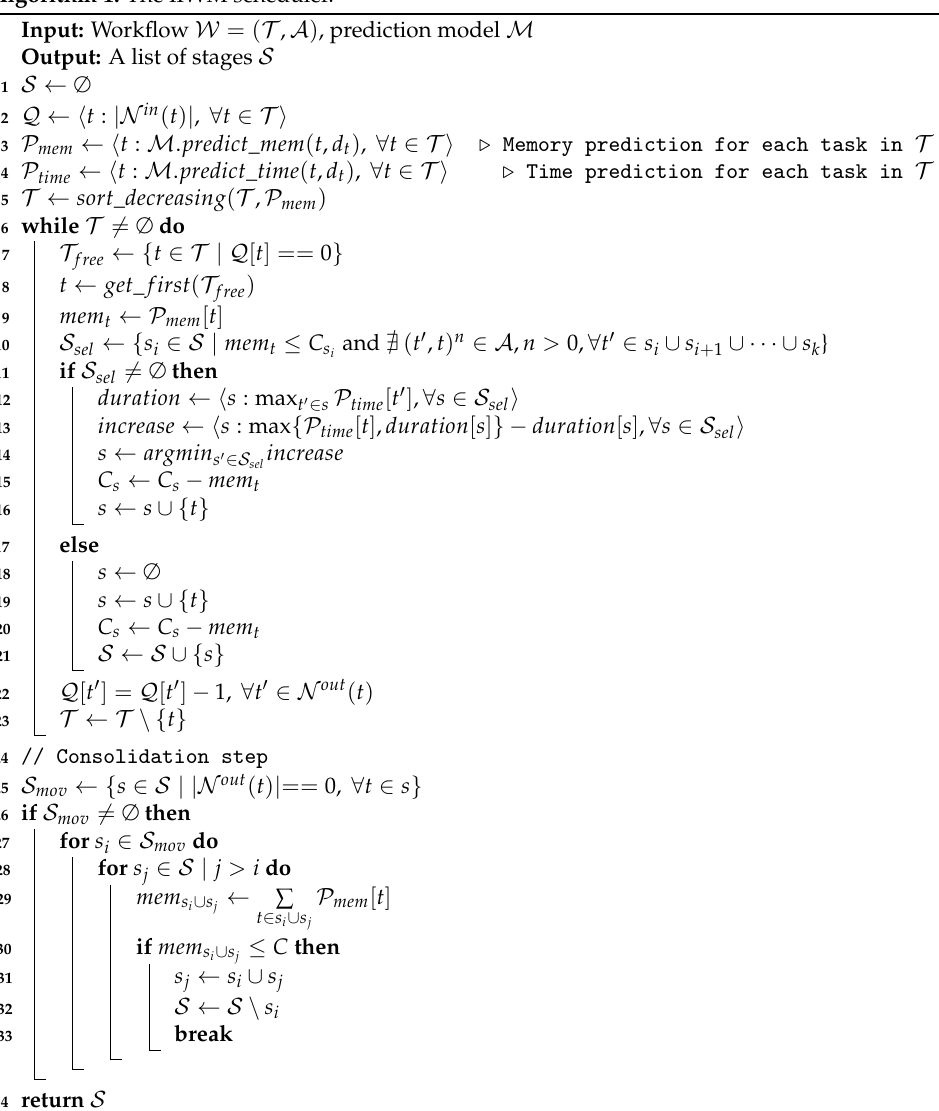
Algorithm 1: The IIWM